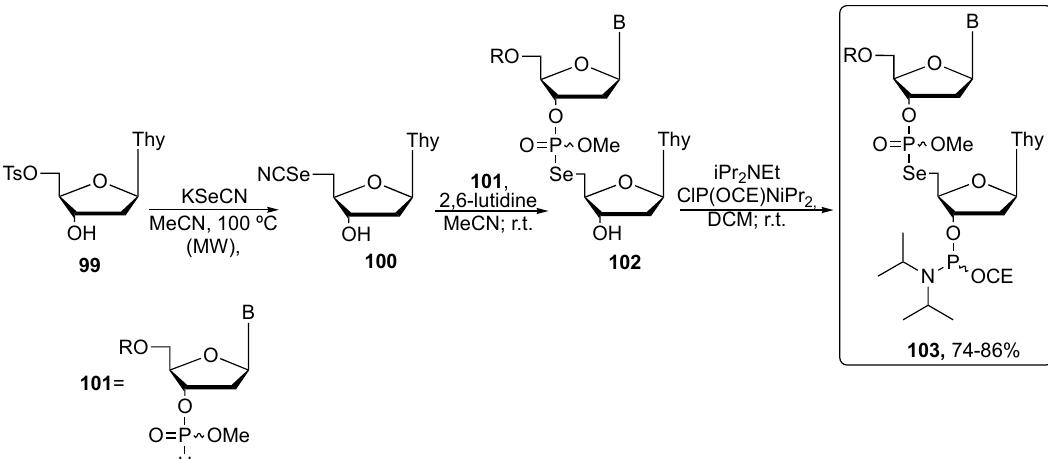
Figure 7. Structures of the phosphoroselenoates synthesized by Stec and studied by